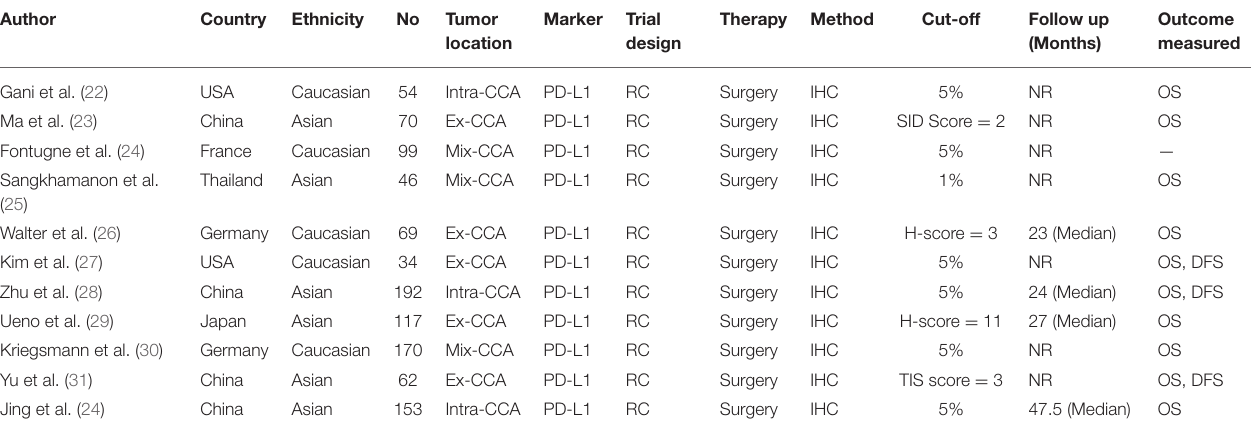
TABLE 1 | The characteristics of studies included in the